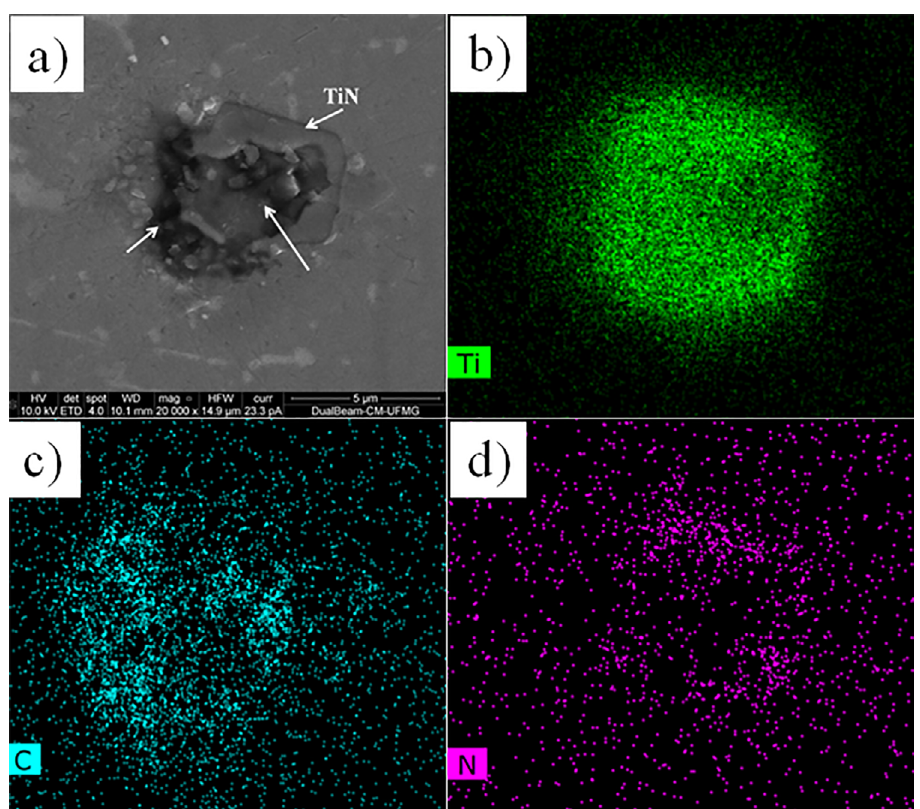
Figure 13. (a) SEM micrograph and (b, c, d) EDS concentration maps of the tempered sample after SVET measurement during